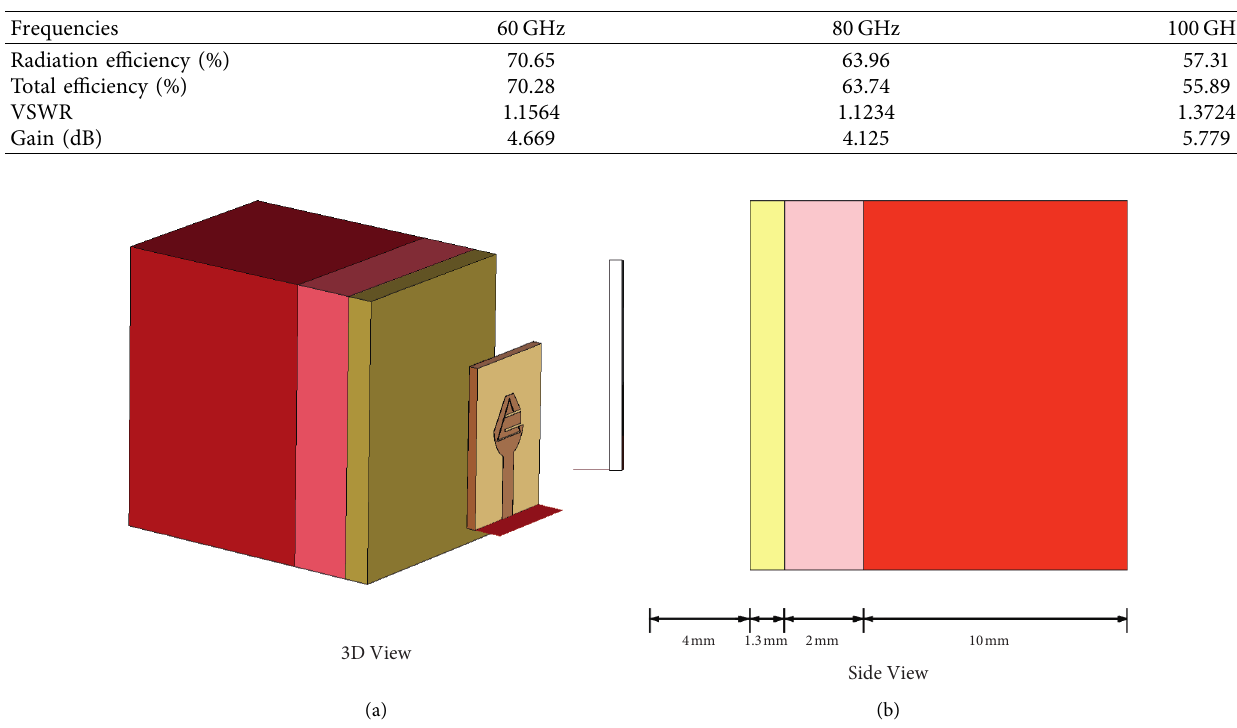
Figure 6: Antenna with human body model: (a) 3D view and (b) side view.